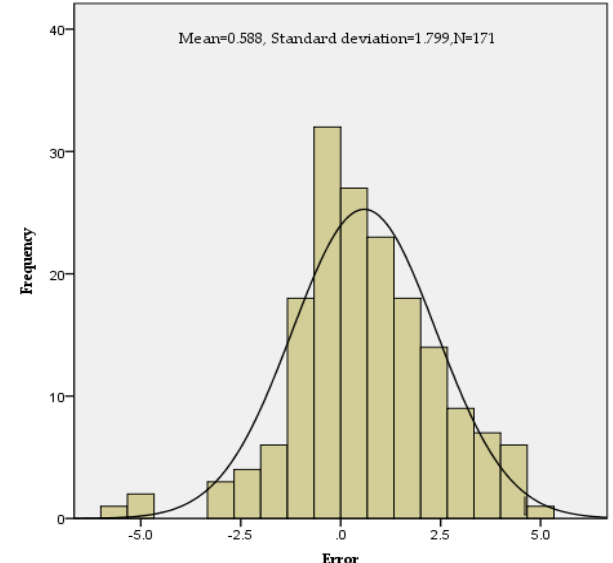
Figure 8. The error probability distribution of T( h –1).